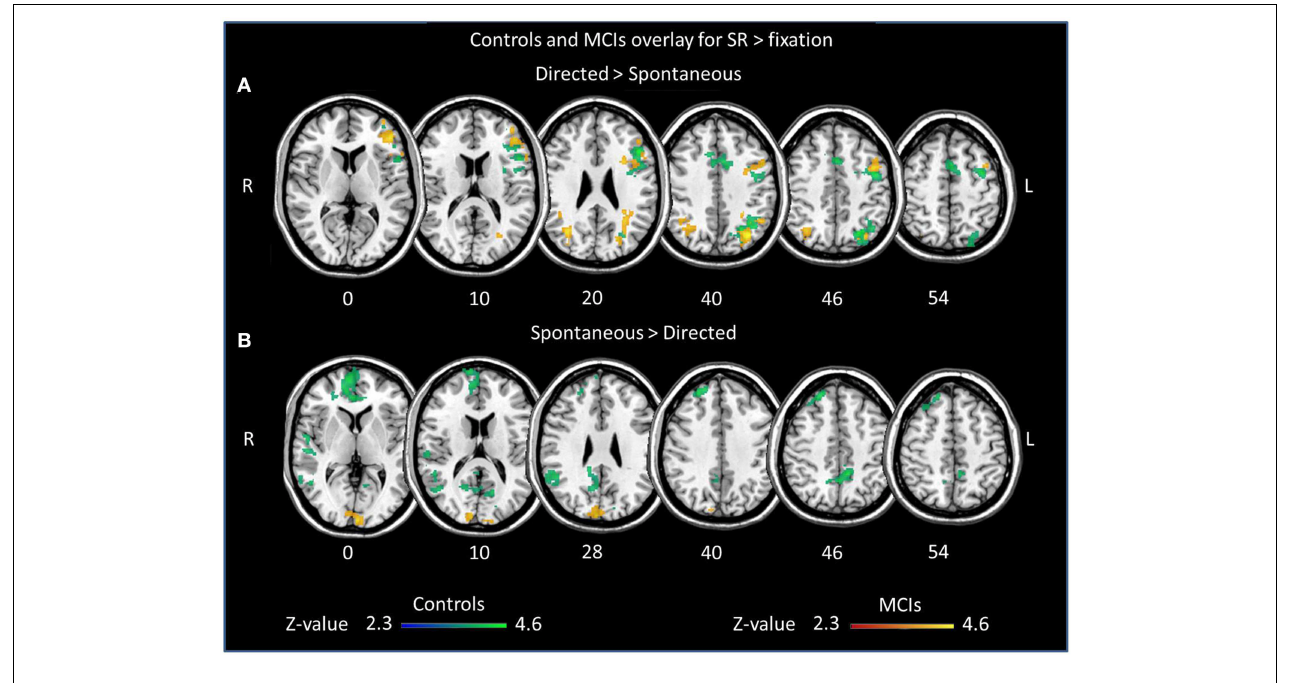
(A) activation and (B) deactivation in the directed session, during the explicit application of the semantic strategy, in comparison to the spontaneous encoding